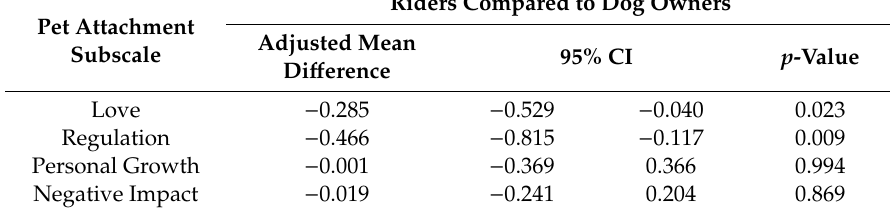
Table 2. Results of general linear model for pet attachment subscales. Regression coefficients representing the adjusted mean difference to dog owners and their 95% confidence intervals and associated p -values are shown .